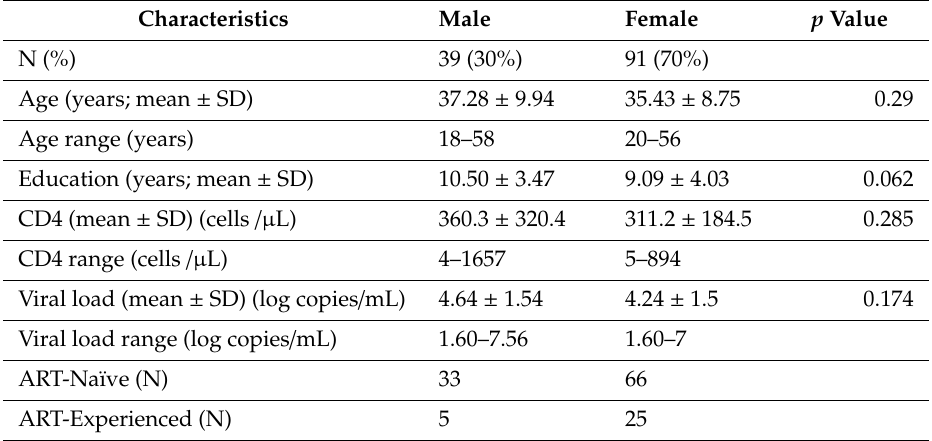
Table 1. Demographic and clinical characteristics of cohort subjects by